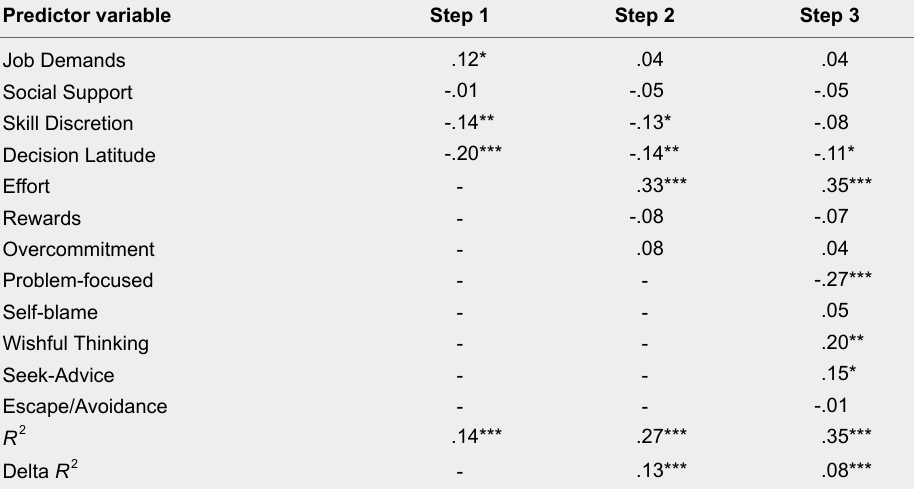
Hierarchical Multiple Regression: DCS, ERI and Coping Variables Against Anxiety (β Values) Predictor variable Step 1 Step 2 Step 3 Job